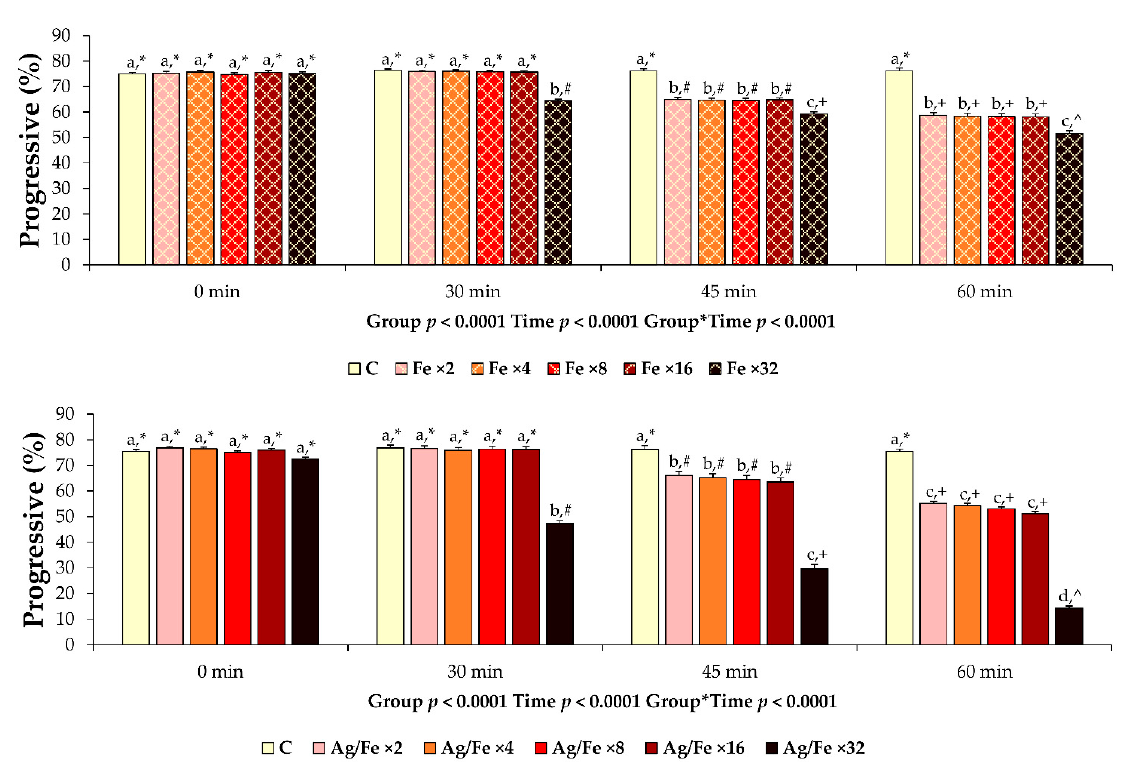
Figure 2. Post treatment progressive motility of liquid extended ram semen samples ( n = 8) co-incubated (15 °C) with different concentrations of Fe 3 O 4 and Ag/Fe nanoparticles (NPs) for 0, 30, 45, or 60 min. Control group (C): Extended ram semen samples-no treatment; iron oxide groups (Fe): Extended ram semen supplemented with different concentrations of Fe 3 O 4 NPs (Fe ×2, Fe ×4, Fe ×8, Fe ×16, Fe ×32 correspond to 0.384 mg, 0.768 mg, 1.536 mg, 3.072 mg, and 6.144 mg of Fe 3 O 4 NPs/mL semen, respectively); silver groups (Ag/Fe): Extended ram semen samples supplemented with different concentrations of Ag/Fe NPs (Ag/Fe ×2, Ag/Fe ×4, Ag/Fe ×8, Ag/Fe ×16, Ag/Fe ×32 corresponds to 0.256 mg, 0.512 mg, 1.024 mg, 2.048 mg and 4.096 mg of Ag/Fe NPs/mL semen, respectively). Values are expressed as LSmeans ± standard error of the mean (SEM). Differences at statistical level between groups are noticed by different superscripts (a, b, c, d). Significant differences between evaluation times within each experimental group are depicted by different symbols (*, #, +, ^).